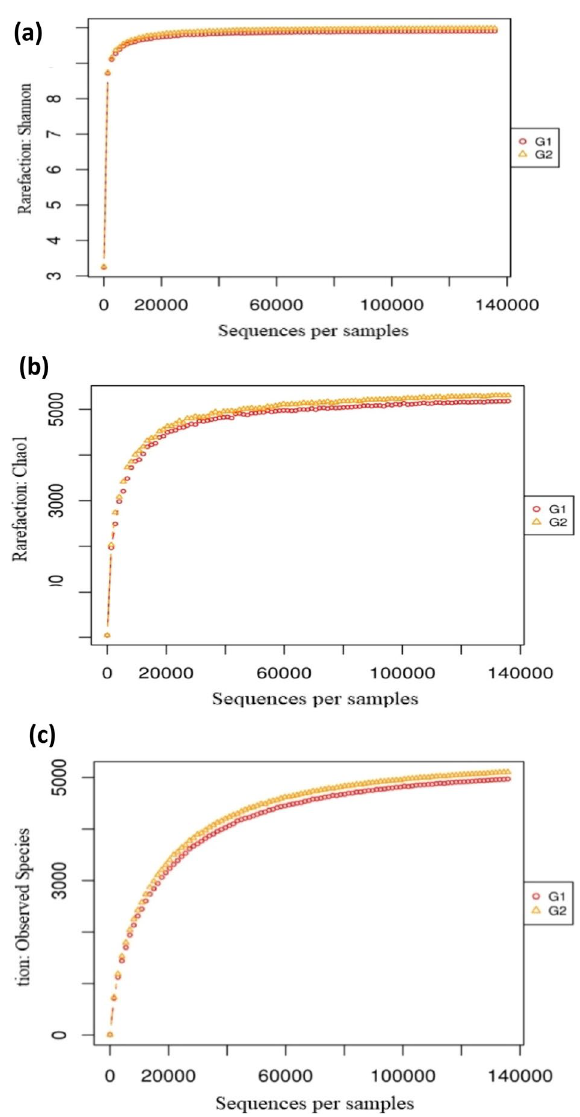
Figure 3. Shanon ( a ), Chao1 ( b ) curves and observed species ( c ) obtained for the samples (G1 and